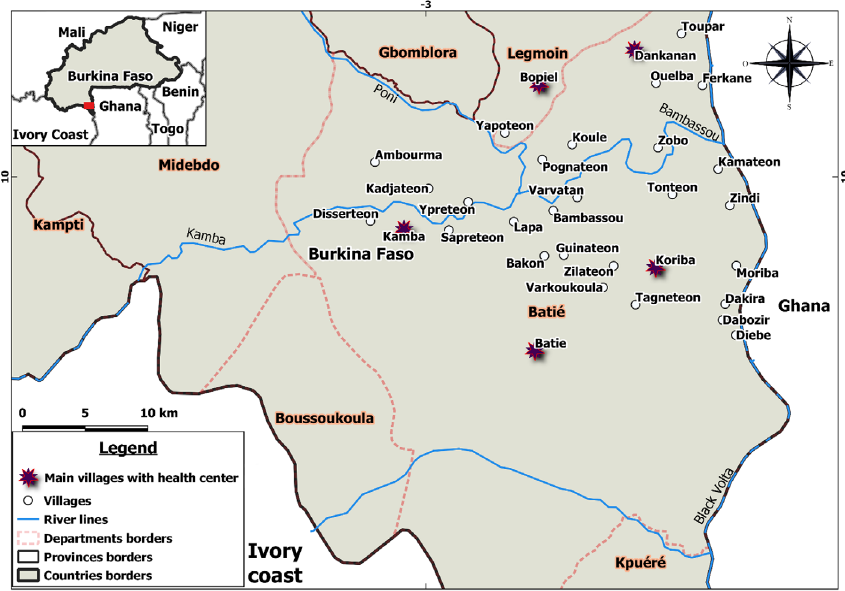
Figure 1. Study area indicating the 29 villages and the fi ve health centers in Batié health district within Noumbiel Province . Kamba and Koriba have a health center and are part of the 29 selected villages, while Bopiel, Batié and Dankanan have a health center but the village was not